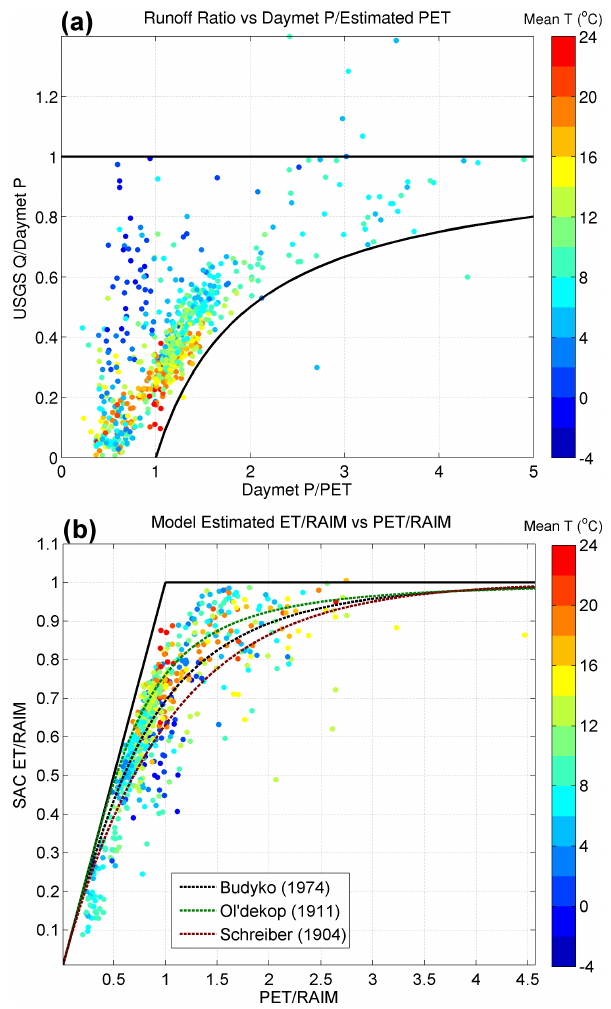
Figure 4. (a) Runoff ratio of observed runoff to Daymet-estimated precipitation versus ratio of Daymet-estimated precipitation to Priestly–Taylor-estimated PET. (b) Model-derived Budyko analy- sis using model ET, PET and total surface water input (rain plus melt, RAIM) for the 671 basins and three derivations of the Budyko curve (dashed lines). Basin mean temperature is shaded (coloring) in both